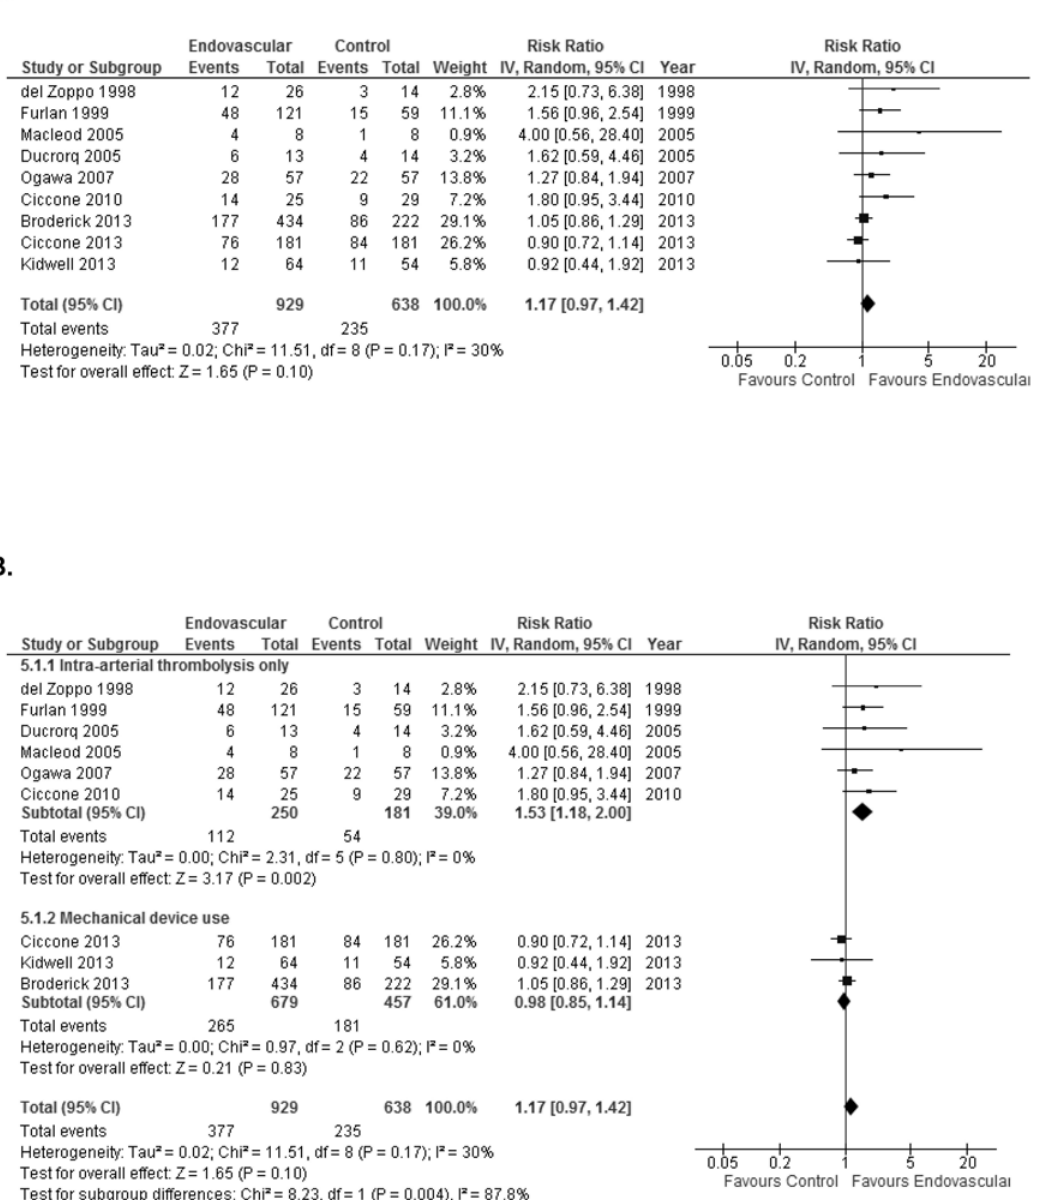
Fig 2. Forest plots showing modified Rankin Score 0 – 2 at 90 days between endovascular therapy and controls. A: All studies. B: Subgroup 1: IA thrombolysis only versus mechanical device use. C: Subgroup 2: Comparator includes IV thrombolysis versus no thrombolysis. D: Subgroup 3: Studies that required vessel occlusion versus studies did not require vessel occlusion